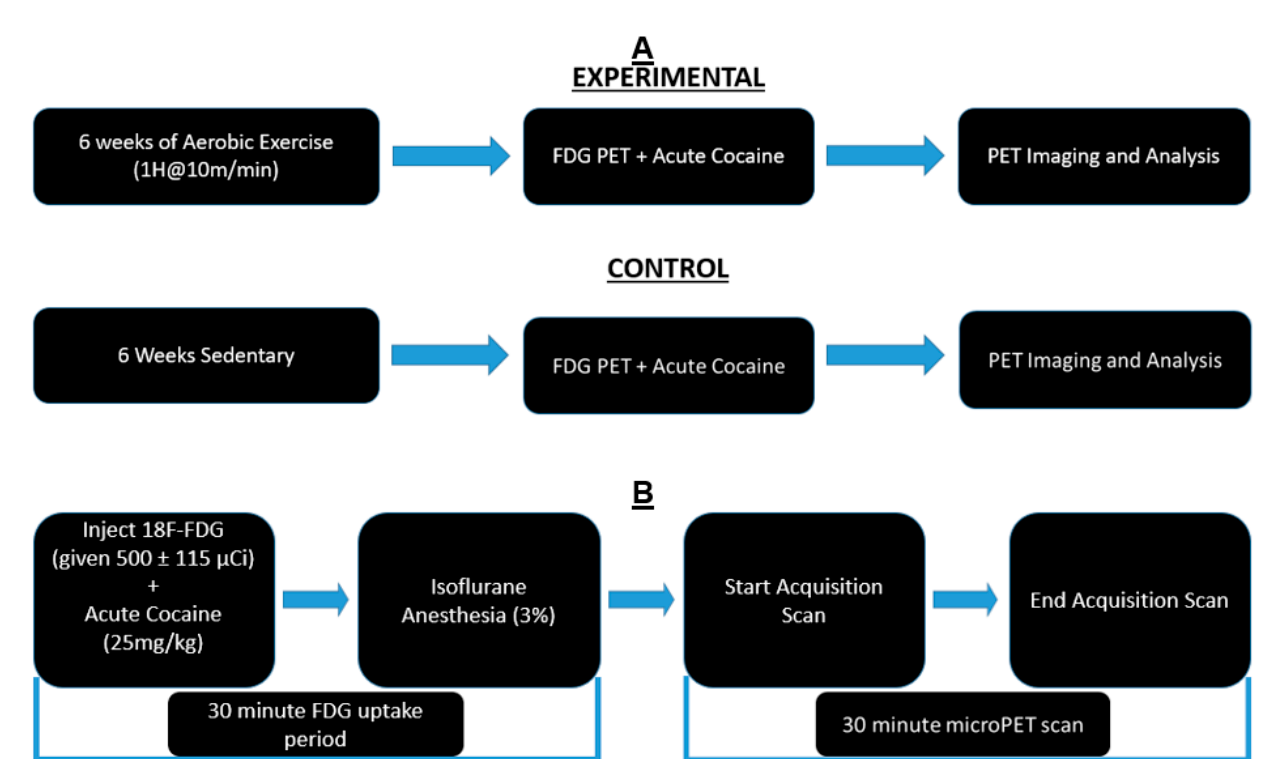
Figure 1. Experimental Timeline: ( A ) Animals were divided into exercise and sedentary groups. Exercise animals received 6 weeks of exercise, while sedentary animals remained in their home cages. All animals underwent PET scans and cocaine injections after the conclusion of 6 weeks. ( B ) Timeline of PET procedure: Animals were injected with [ 18 F]-Fluorodeoxyglucose (FDG) and cocaine solution via intraperitoneal injection. They were returned to their home cages for a 30-min uptake period. At the end of the uptake period, animals were anesthetized and placed in the bed of the PET R4 tomograph machine. PET scans lasted 30 min. After the scan, animals were recovered and returned to their home cages.